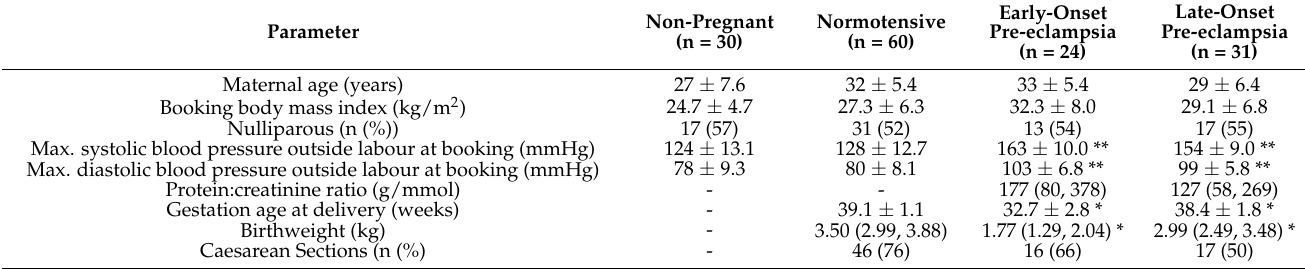
Table 1. Demographic, clinical and biochemical data of